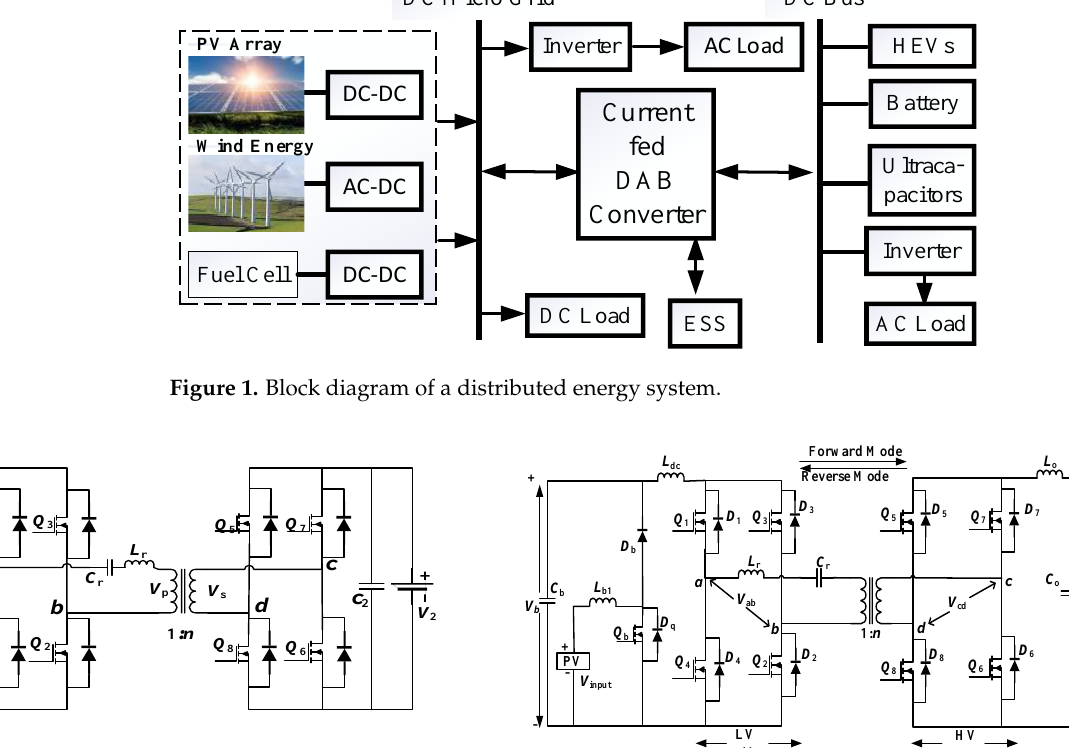
Figure 2. Isolated Bidirectional DC – DC Converter ( a ) Voltage-fed DAB converter ( b ) Current-fed DAB converter.